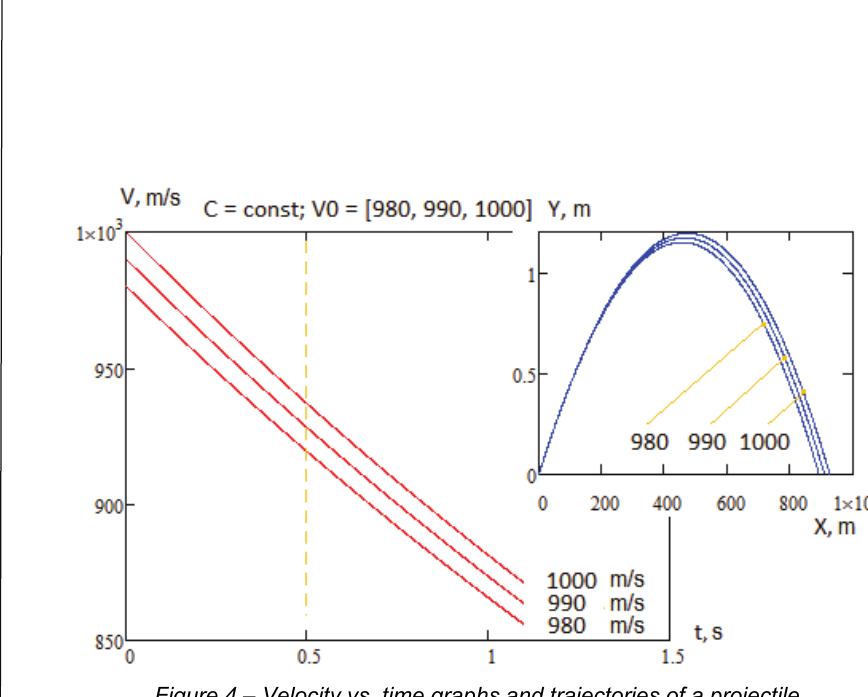
Figure 4 – Velocity vs. time graphs and trajectories of a projectile Рис . 4 – Графики изменения скорости и траектории снаряда Слика 4 – Графички прикази брзине и путање